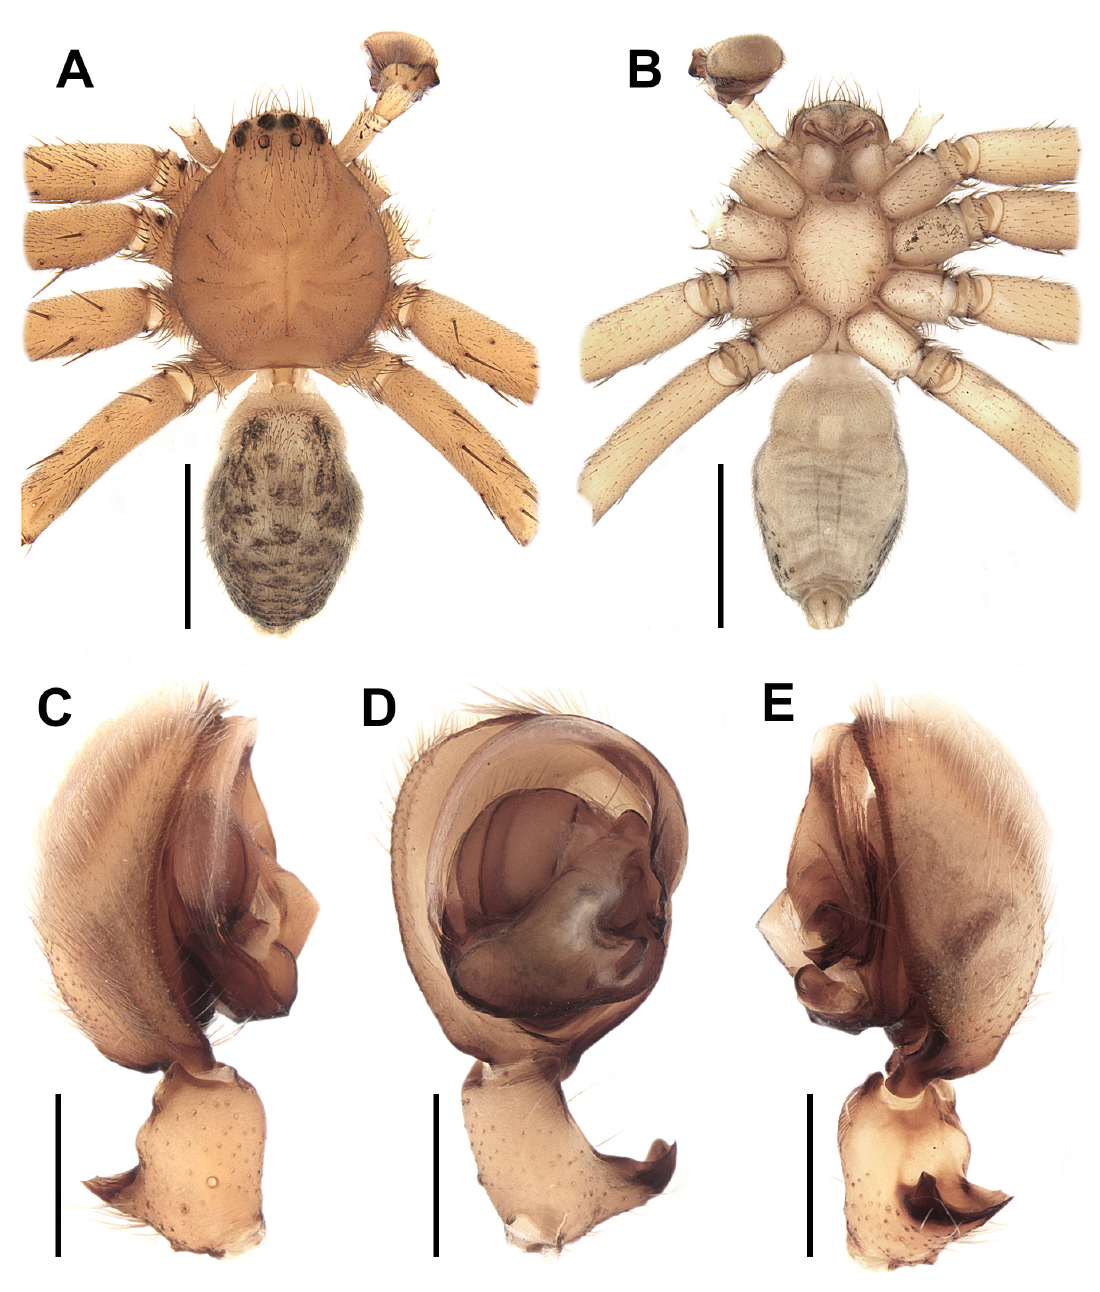
Fig. 8. Cuiambuca vacabrava sp. nov., holotype, ♂ (IBSP 60013). A . Habitus, dorsal view; B . Habitus, ventral view. C . Left palp, prolateral view. D . Left palp, ventral view. E . Left palp, retrolateral view. Scale bars: A−B = 2.0 mm; C−E = 0.5